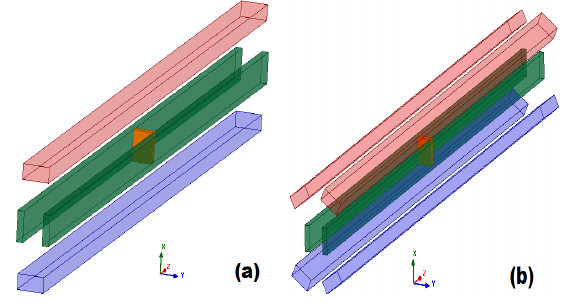
Figure 12: Three-dimensional structures of the permanent magnet augmented railgun: (a) augmented railgun with 2 magnets. (b) Augmented railgun with 4 magnets.